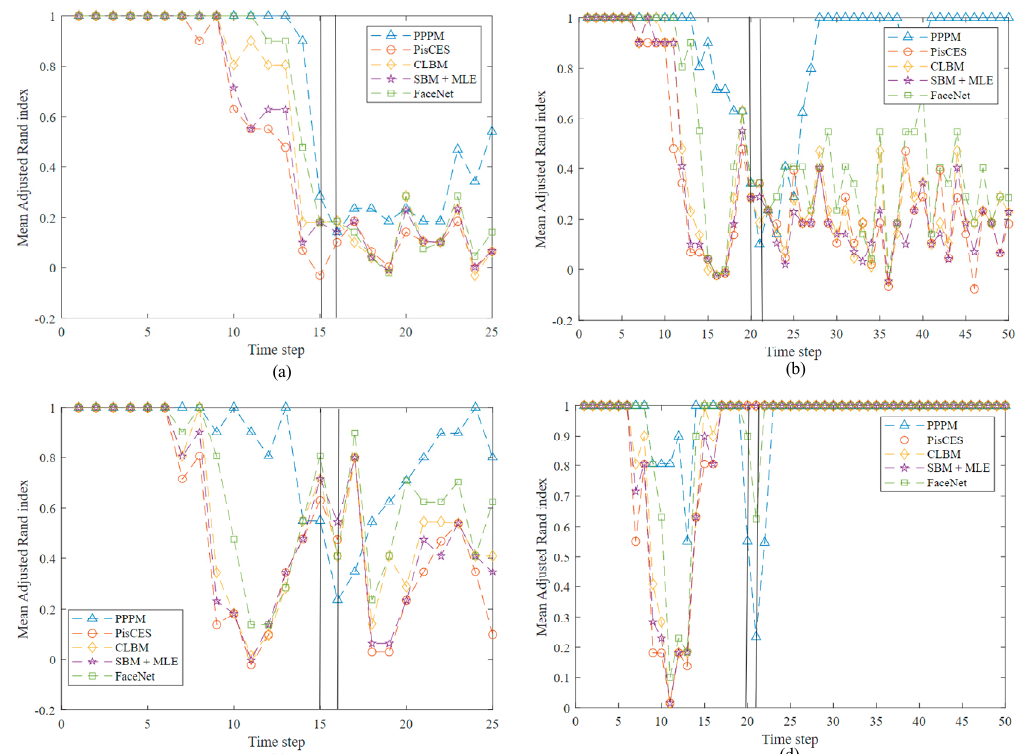
Figure 5. Comparison of the proposed model with 4 different models on Mean ARI (synthetic net- work). (a) indicates that the time step is 25 and the randomly selected parameter is 10%, (b) indicates that the time step is 50 and the randomly selected parameter is 10%, (c) indi- cates that the time step is 25 and the randomly selected parameter is 20%, (d) indicates that the time step is 50 and the randomly selected parameter is 20%.